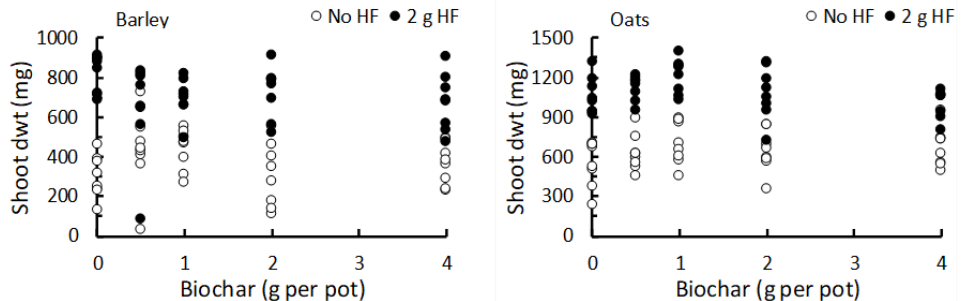
Figure 5. The response of barley and oats (shoot dry weight, dwt; mean ± se; N = 8 per treatment) grown under greenhouse conditions to different application rates of powdered biochar created from olive stones and hardwood feedstock. The biochar treatments were combined with the addition of HexaFrass at two rates (0 g and 2 g per pot) to produce ten treatments in total for each plant species.